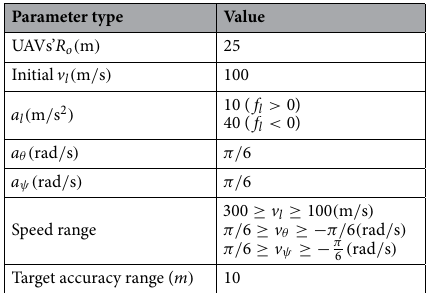
Table 1. Performance parameters.